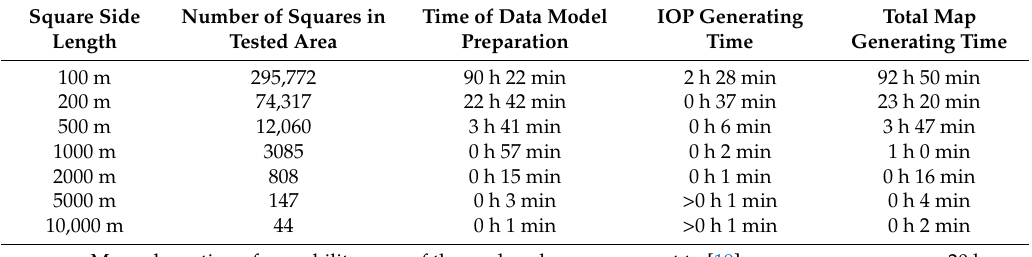
Table 13. Map generating time.